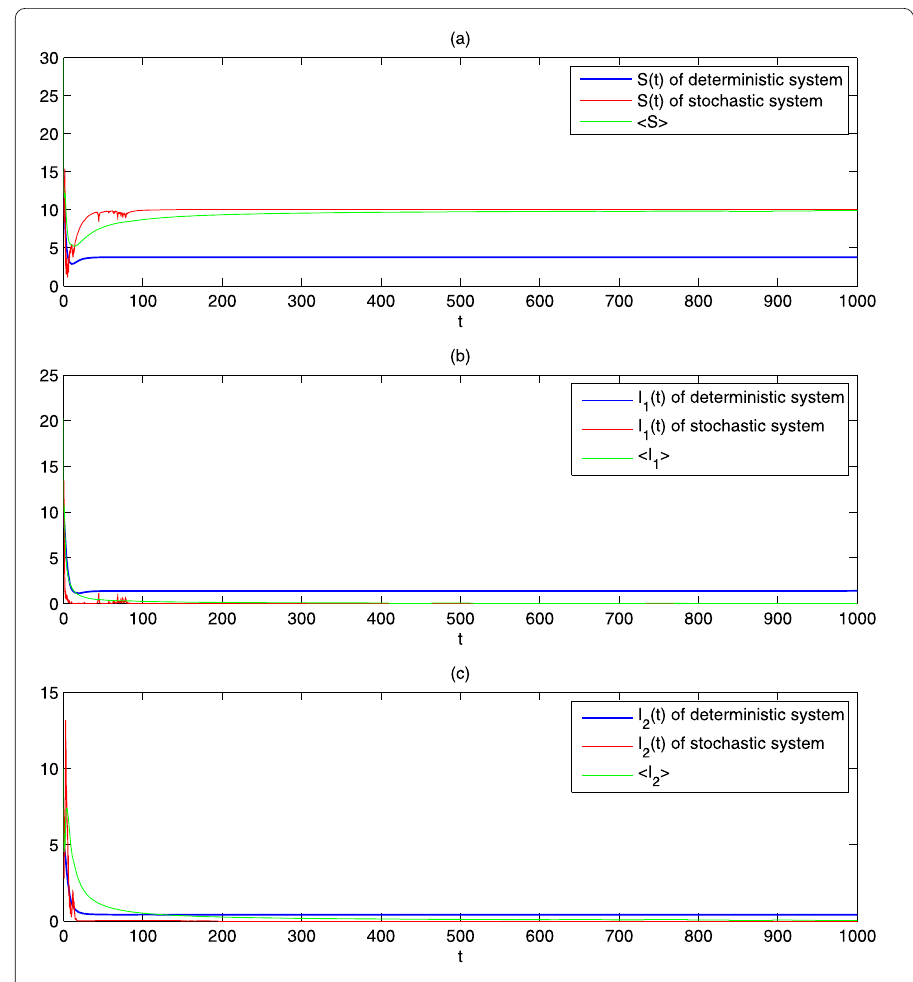
Figure 2 Dynamic behaviour comparisons of S ( t ), I 1 ( t ), I 2 ( t ) in the deterministic and the stochastic SIS system with parameters A = 1, d = 0.1, β 1 = 1.2, β 2 = 1.5, a 1 = 1, a 2 = 1.5, b 1 = 2, b 2 = 1, α 1 = 0.2, α 2 = 0.4, r 1 = 0.3, r 2 = 0.3, σ 1 = 1.2, σ 2 = 1.2. (a) Time series for S ( t ) and (cid:5) S ( t ) (cid:6) . (b) Time series for I 1 ( t ) and (cid:5) I (cid:6) . (c) Time series for I (cid:5) I (cid:6) 1 ( t ) 2 ( t ) and 2 ( t )